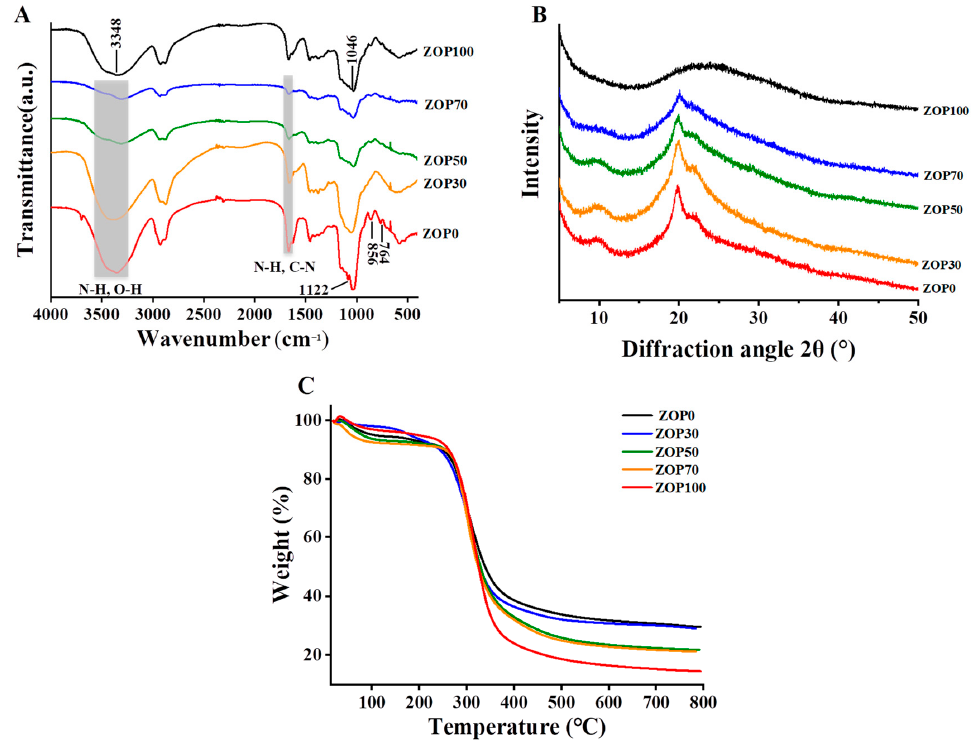
Figure 4. FT-IR spectra of different hydrogels ( A ); XRD of different hydrogels ( B ); TGA of different hydrogels ( C ).